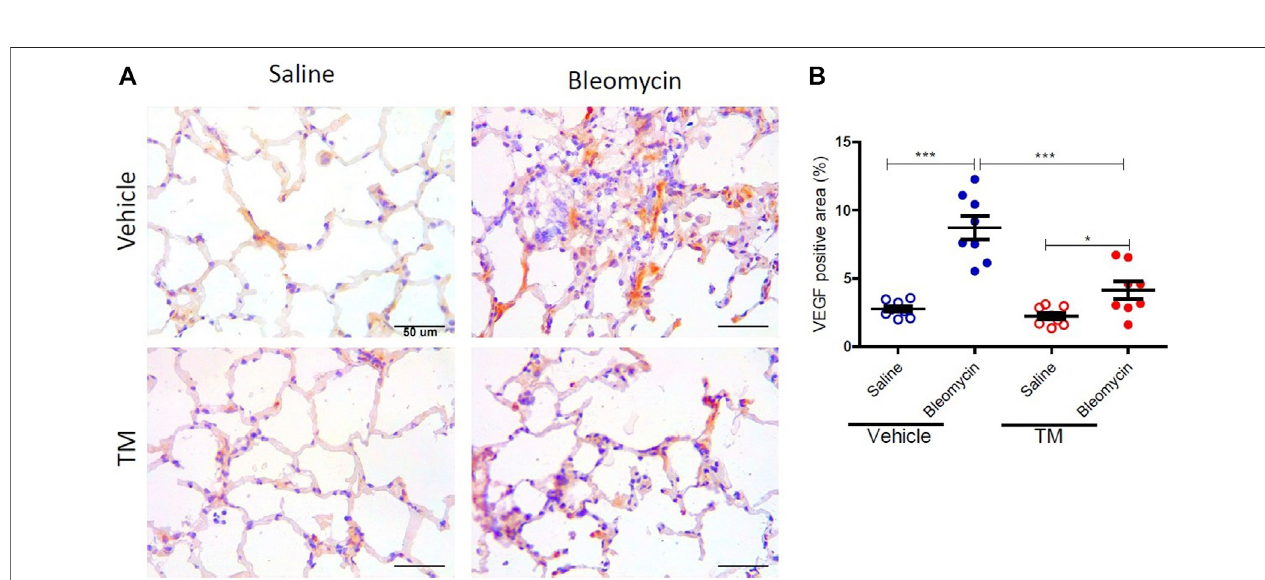
FIGURE 4 | Tetrathiomolybdate downregulates bleomycin-induced VEGF expression. (A) Representative photomicrographs showing anti-VEGFA immuno- stained lung tissue sections of saline and bleomycin-infused lung segments from either vehicle (sterile saline) or tetrathiomolybdate treated sheep. In each animal, one lung segment was infused with saline (left-side images) whereas the contralateral segment was infused with bleomycin (right-side images). (B) Shows the data for the percentageVEGF-stainedareapertotalareaofthelungparenchymainthe fi eldofviewforthedifferenttreatmentgroups.Signi fi cancewasanalyzedusingapaired t -test between saline- vs . bleomycin-infused segments from the same animals and an unpaired t -test between segments from different animals (vehicle vs . TM treated animals), n (cid:1) 10 sheep, * p < 0.05, *** p < 0.001. Scale bars (cid:1) 50 µm.